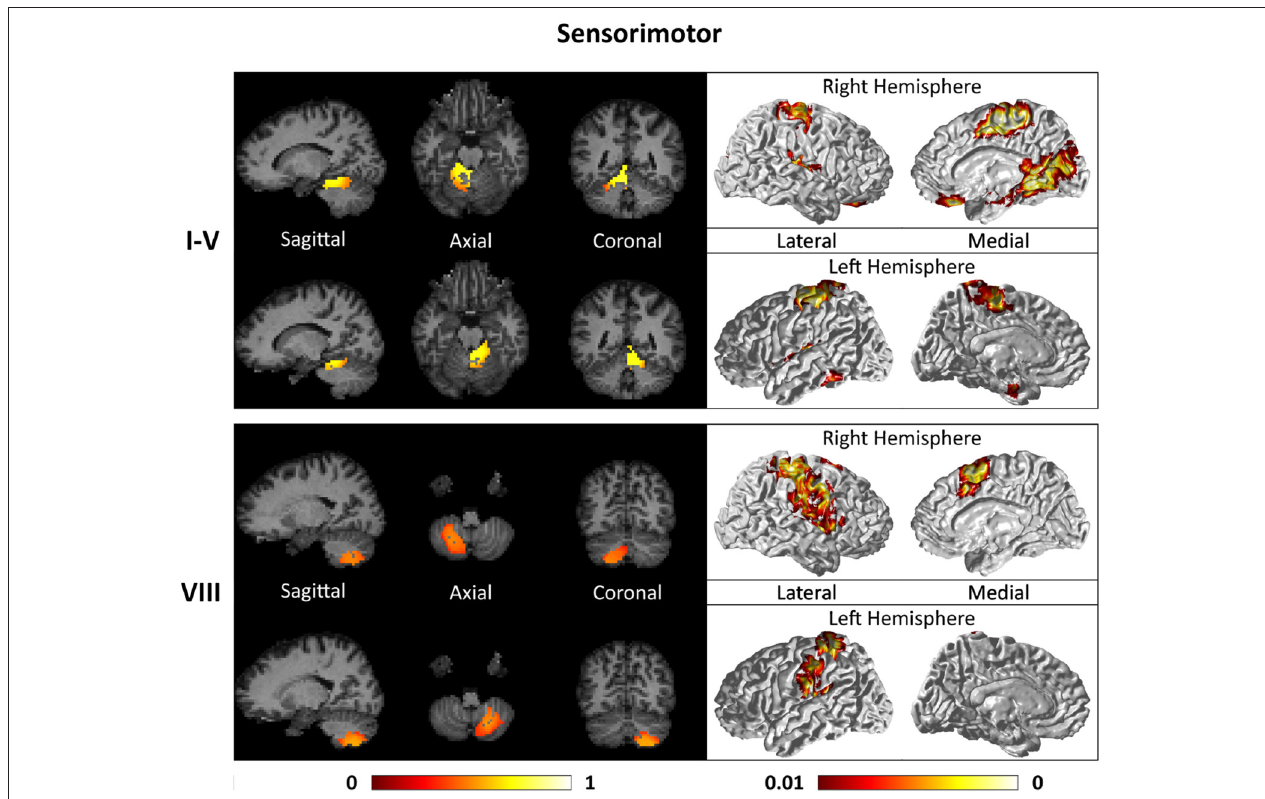
FIGURE 7 | Cerebellar clusters (left column) that correspond to lobules I–V (first row) and VIII (second row) are found to be functionally connected to sensory and motor cortical regions (right column).